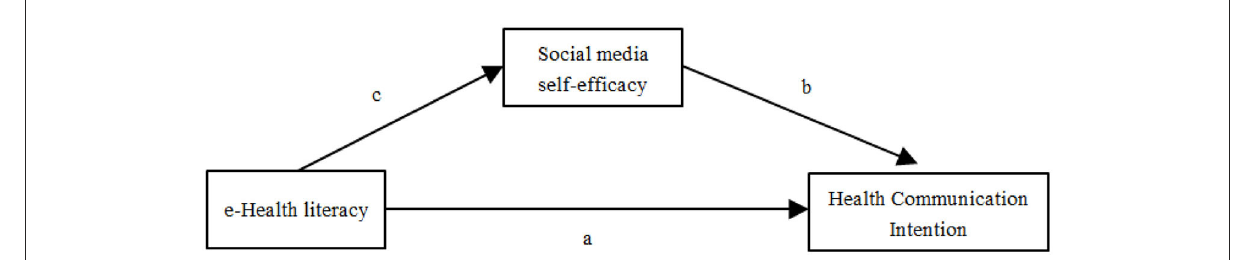
FIGURE1 Hypothesized model. a: There is a positive relationship between eHealth literacy and the intention of nursing undergraduates to participate in health communication (hypothesis 1); b: The higher the level of social media self-efficacy of nursing undergraduates, the stronger their intention to communicate about health (hypothesis 2); c: Social media self-efficacy mediates the impact of eHealth literacy on health communication intention (hypothesis